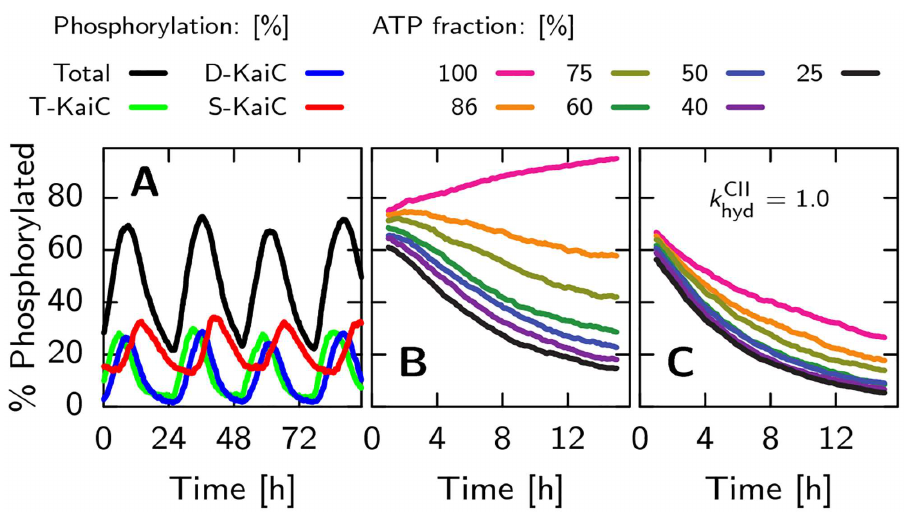
Fig 11. An alternative model, without hydrolysis in the CII domain, can generate robust macroscopic oscillations. (A) Time traces of monomers in the T state (green), D state (blue), S state (red) and total phosphorylation level (black), at 50% ATP level in the bulk, for the alternative model with hydrolysisonly in the CI domain.(B) Dephosphorylationof KaiC for different bulk fractions of ATP, α ATP . Due to the high nucleotide exchangerate of the CII domainin the inactive conformation, the dephosphorylationspeedbecomes sensitive to α ATP , contrary to what is observedexperimentally. (C) Even when we add the hydrolysisof ATP in the CII ¼ 1 , the speedstill dependson α ATP domain, k CII hyd